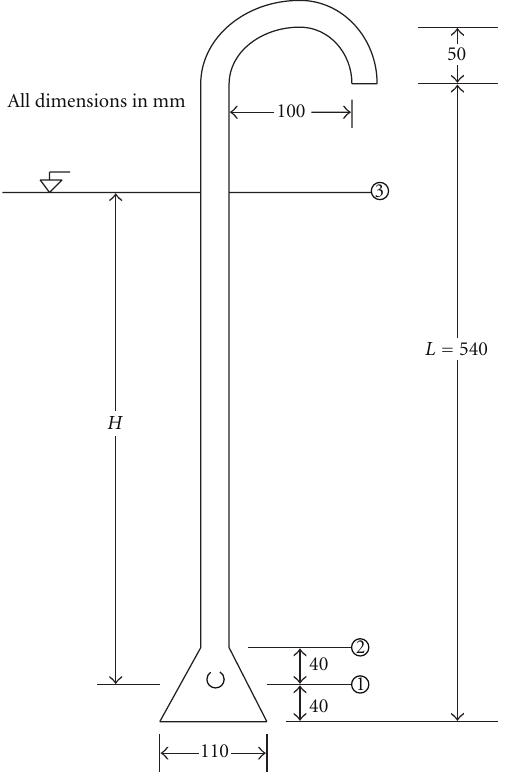
Figure 1: Model airlift pump with rectangular